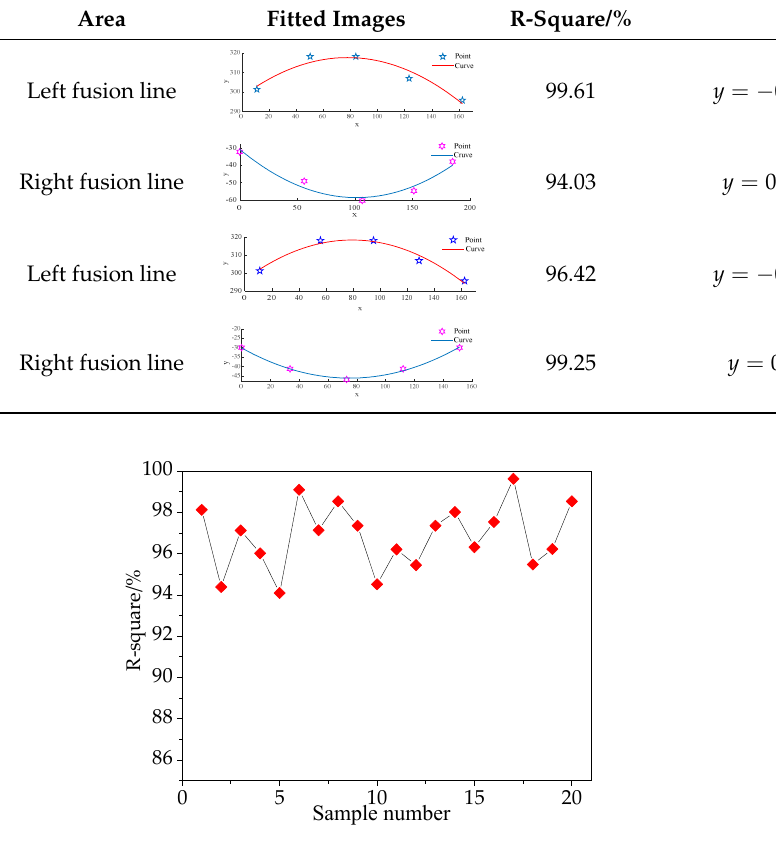
Figure 8. Comparison of decision coefficients R-square.